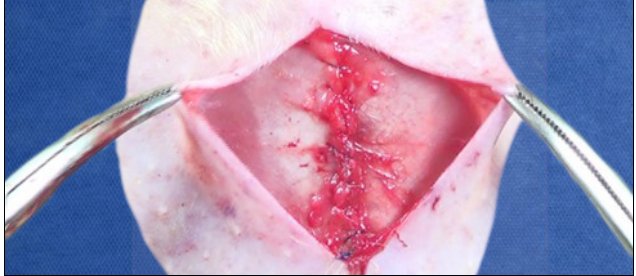
Figure 3 - Approximation of the rectus abdominis muscle sheaths by means of continuous suture with Prolene 5-0